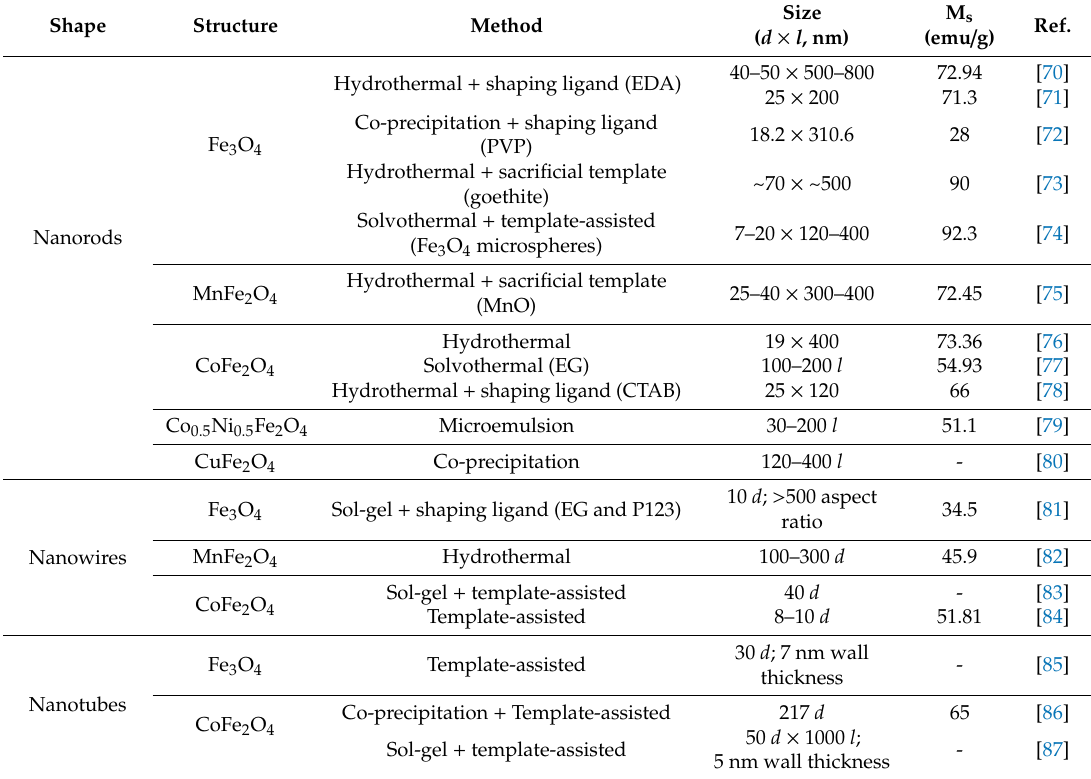
Table 2. Common methods used in the synthesis of elongated iron oxide-based nanoparticles. The size and saturation magnetization, M s , values are also